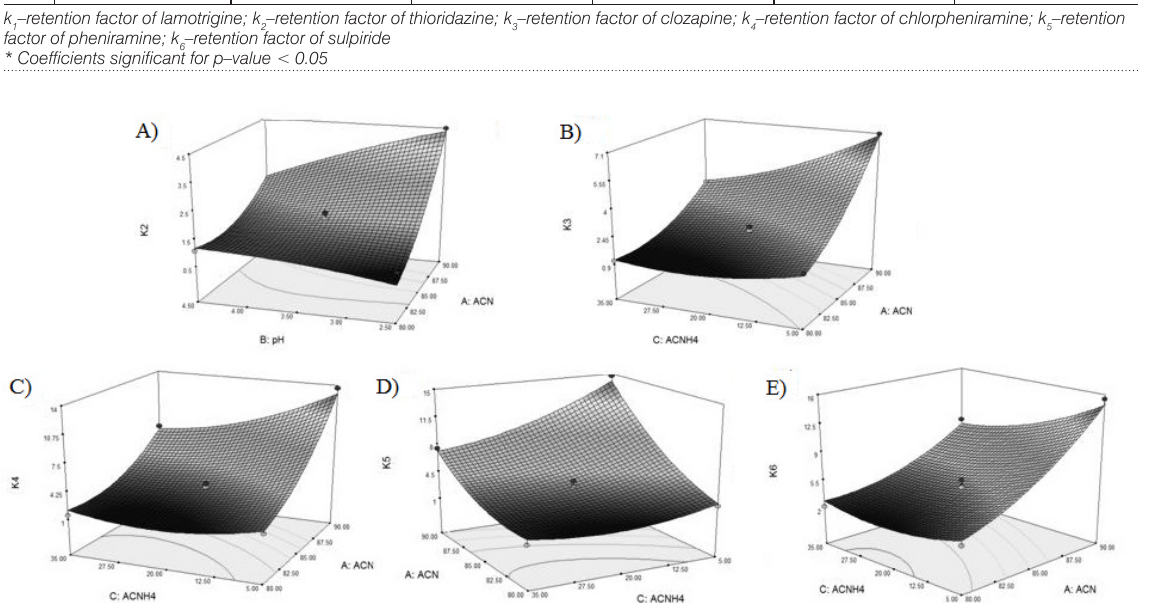
= f (acetonitrile concentration, ammonium 3